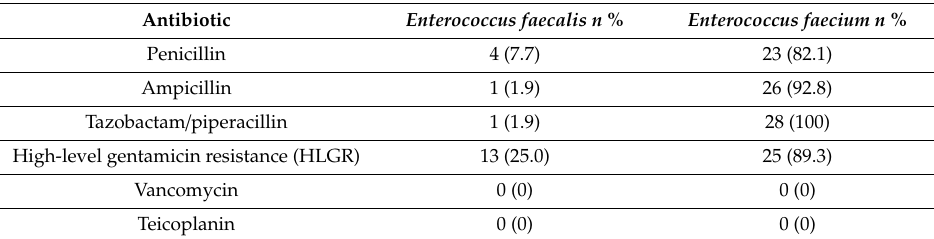
Table 1. Rates of antibiotic resistance in clinical enterococci.